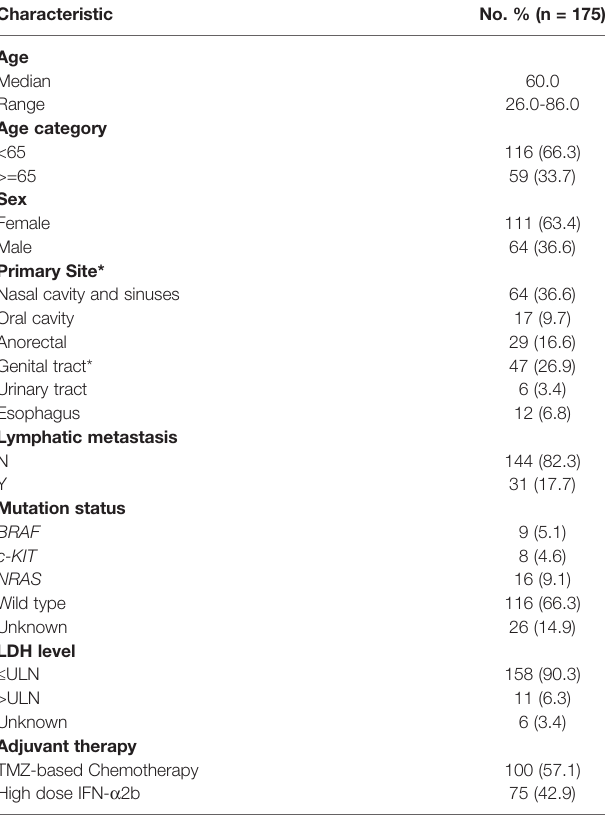
TABLE 1 | Baseline demographics, clinical characteristics and adjuvant therapy regimens of resectable MM patients.